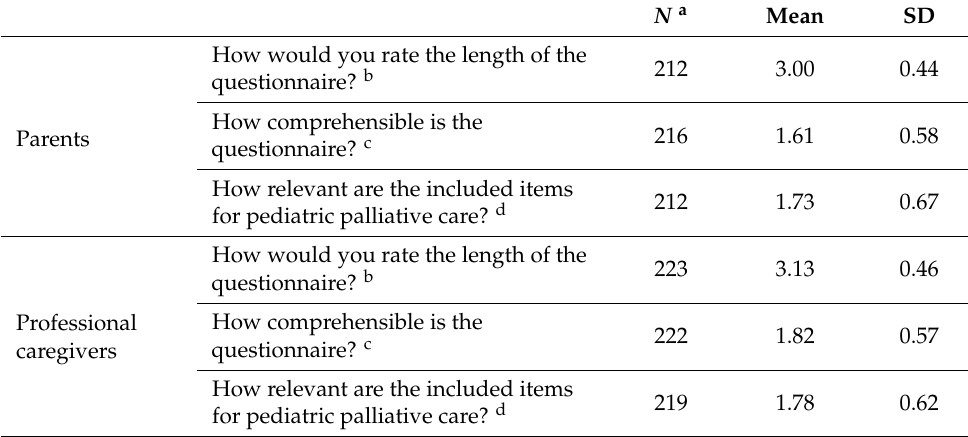
Table 2. Descriptive results of the analysis of the evaluation